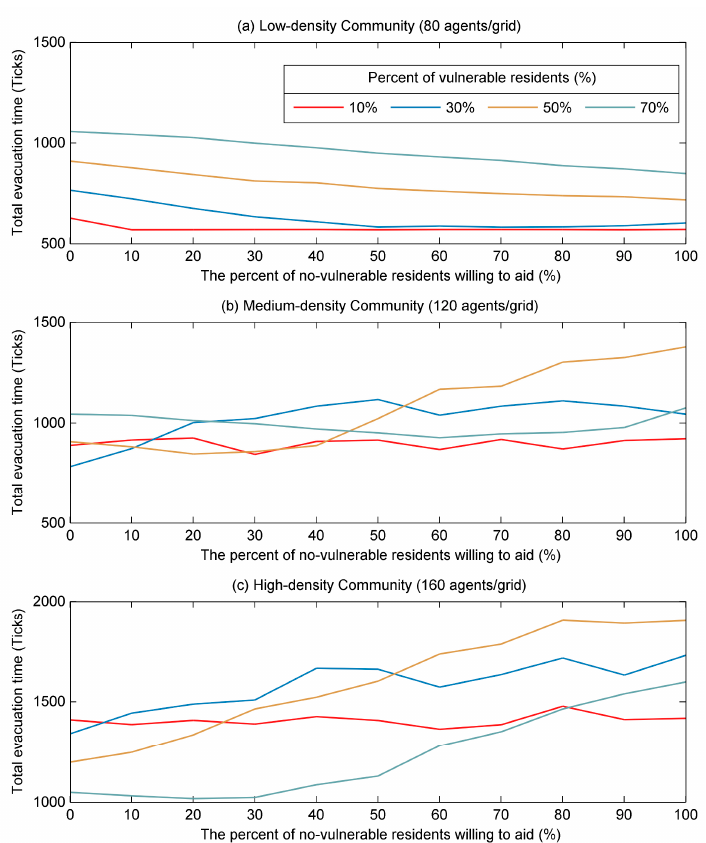
Figure 10. The impacts of the percent of non-vulnerable residents willing to aid on the total evacuation time. ( a – c ) The community density is 80, 120, and 160 agents / grid, respectively representing low-density, medium-density and high-density community. The percent of vulnerable residents (v) was set as 10%, 30%, 50%, and 70%.